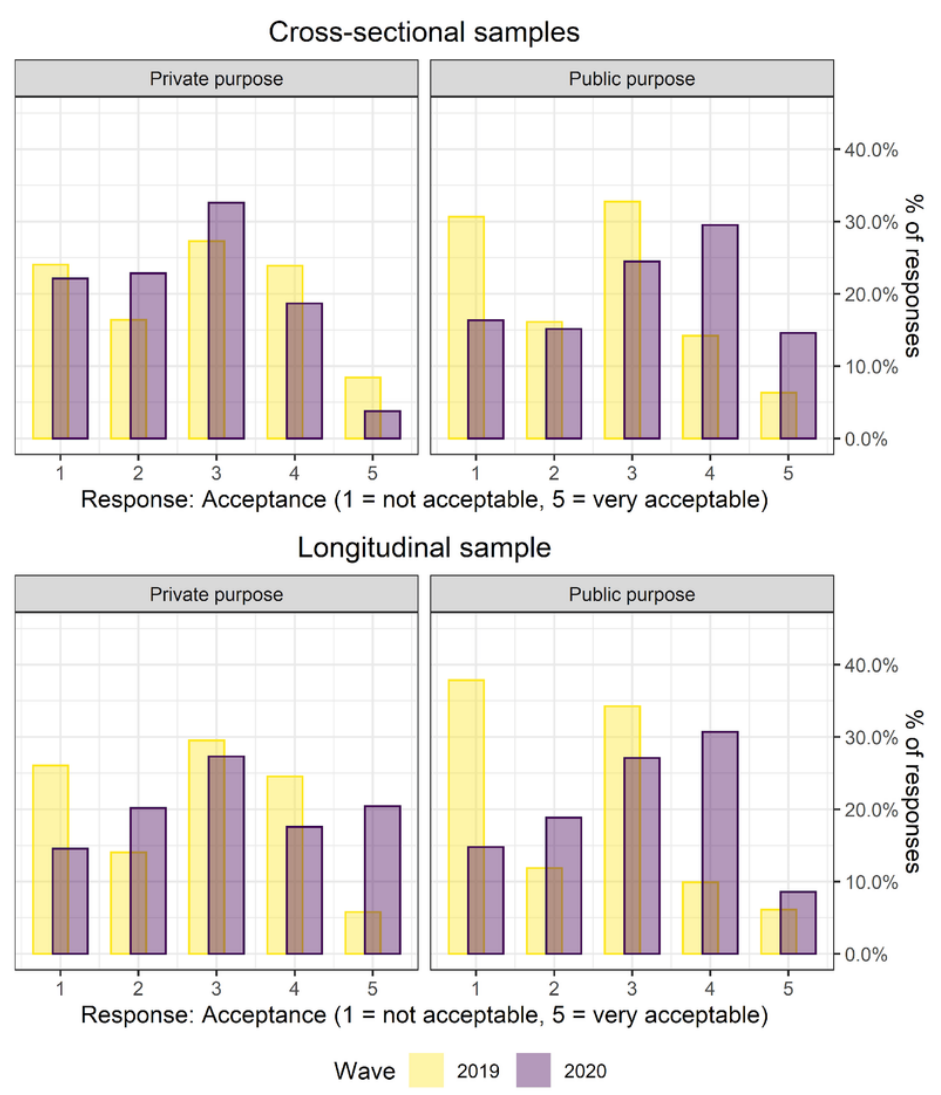
Figure 5. Relative frequency of acceptance for respondents shown a health vignette with a public purpose or a health vignette with a private purpose, by wave. Cross-sectional samples: N = 784. Longitudinal sample: N = 203 per wave. Weighted